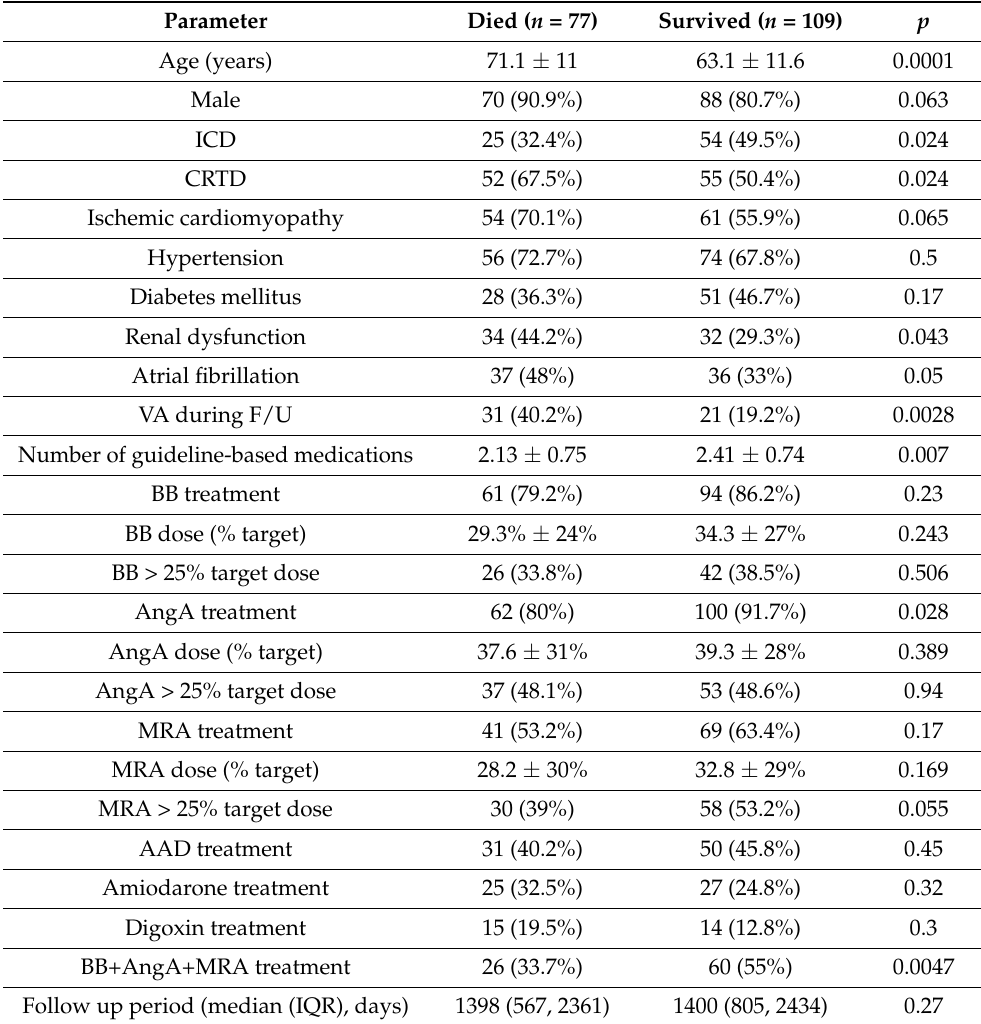
Table 4. Characteristics of patients who died or survived